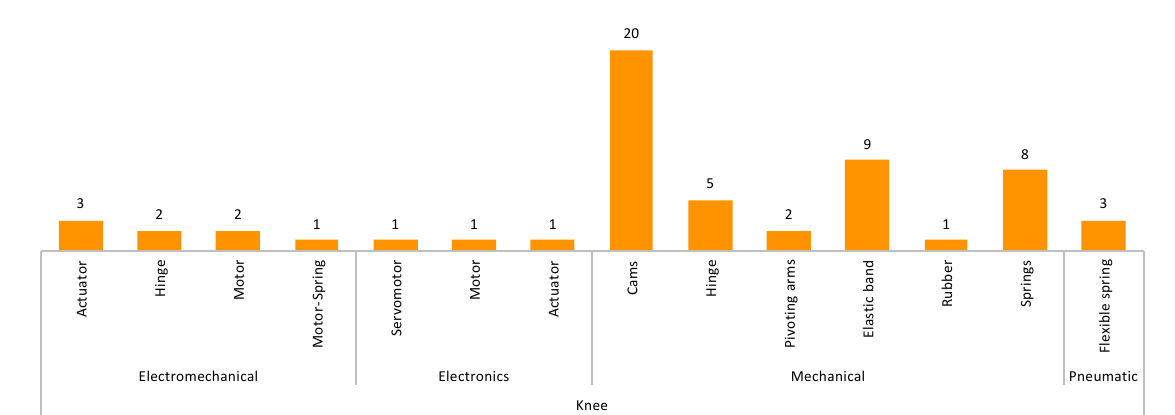
Figure 8. Type of technology used in the knee joint. Table 3. Lower limb exoskeletons and orthoses patents.